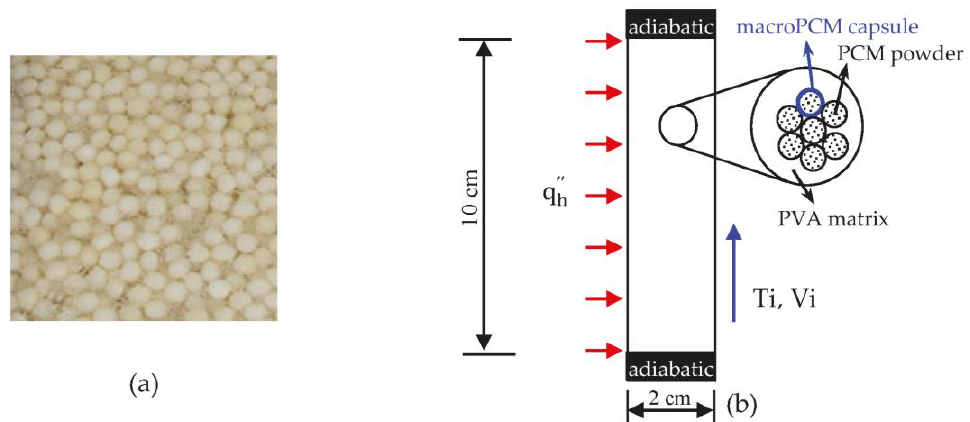
Figure 2. Investigated target and physical model: ( a ) Investigated target (macroPCM wall tile); ( b ) Physical model (macroPCM wall tile) (not to scale).